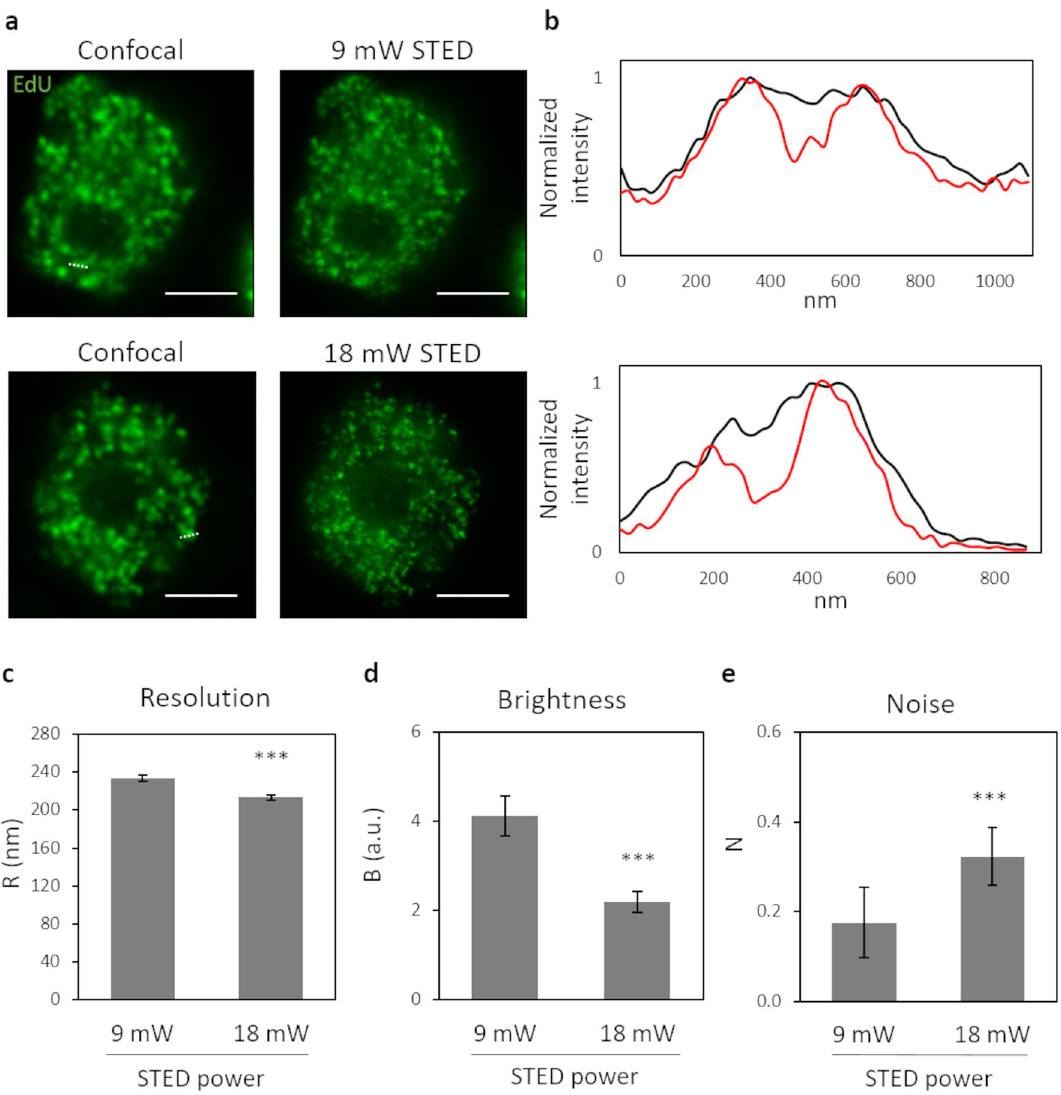
Figure 2. Tuning of STED depletion power. ( a ) Representative images of U937-PR9 cells upon staining of DNA replication foci through incorporation of EdU labeled with Alexa azide 488 (Click reaction). (top) Sequential acquisition of a confocal image, followed by a STED image with a 9 mW depletion beam. (bottom) Sequential acquisition of a confocal image, followed by a STED image with a 18 mW depletion beam. Scale bars represent 3 µm. ( b ) Line profiles of structures from images in ( a ). (top) Comparison between the line profiles of the same structure in the confocal (black line) and the STED (red line) images in the top row of ( a ). The measured structure is defined by a white dotted line in the confocal image. (bottom) Comparison between the line profiles of the same structure in the confocal (black line) and the STED (red line) images in the bottom row of ( a ). The measured structure is defined by a white dotted line in the confocal image. ( c – e ) Quantification of Resolution, Brightness, and Noise parameters by application of the QuICS algorithm. At least ten images for each condition have been acquired. Error bars represent the standard error of the mean (SEM) and ***p < Increasing number of scans average per line. The common approach for reducing the noise in an image is to increase the number of collected photons per pixel. In general, this can be achieved by tuning the number of scans for each pixel and then averaging the intensity values for each pixel position. To evaluate how increasing averages would influence the quality of the image, we acquired sequential STED images of the same cell, with a depletion beam power of 18 mW (see “Methods” for a detailed description of the sequential acquisition settings). From each sequential acquisition, we generated STED images with a different number of line-averages (Fig. 3a) and applied the QuICS algorithm. As expected, the image’s noise significantly decreased following doubling of the number of lines averaged (Fig. 3b). On the other hand, the average resolu- tion R did not improve with an increasing number of lines in the average (Fig. 3c). The brightness B decreased as a function of the number of averages (Fig. 3d) indicating a reduction of the contrast.